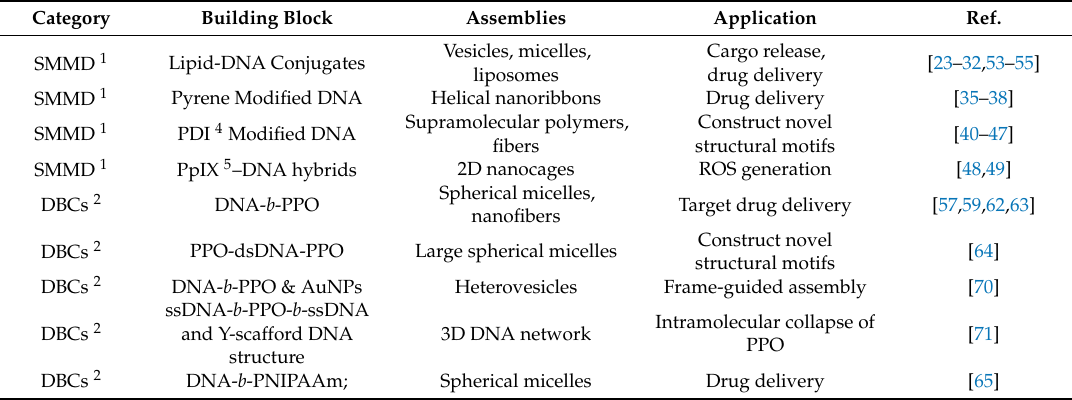
Table A1. The self-assembly of the amphiphilic DNA–organic molecule hybrids and their application.